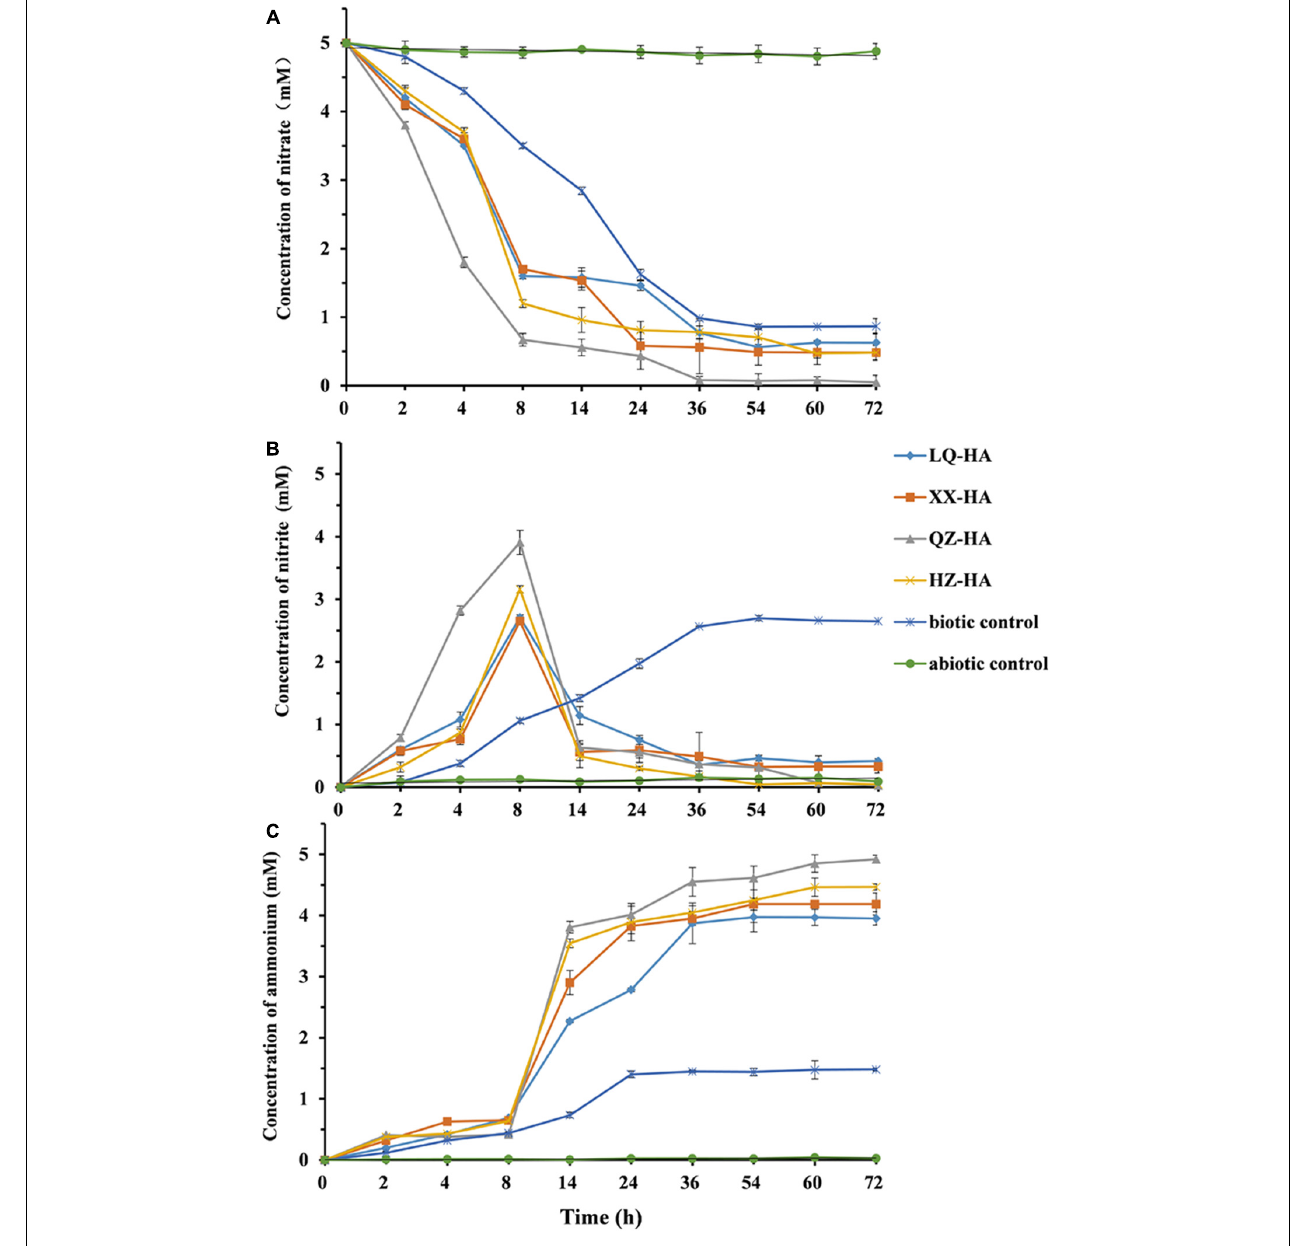
FIGURE 4 | The changes in the concentration of nitrate (A) , nitrite (B) , ammonium (C) left in the culture within 72 h, in which microbial reduction were conducted by MR-1 in the presence of HAs of different origins (LQ-HA, XX-HA, QZ-HA, and HZ-HA) when 5 mM nitrate was added as the electron acceptor in each culture. Data show the mean values of triplicate cultures, and vertical bars show the difference in triplicate cultures.